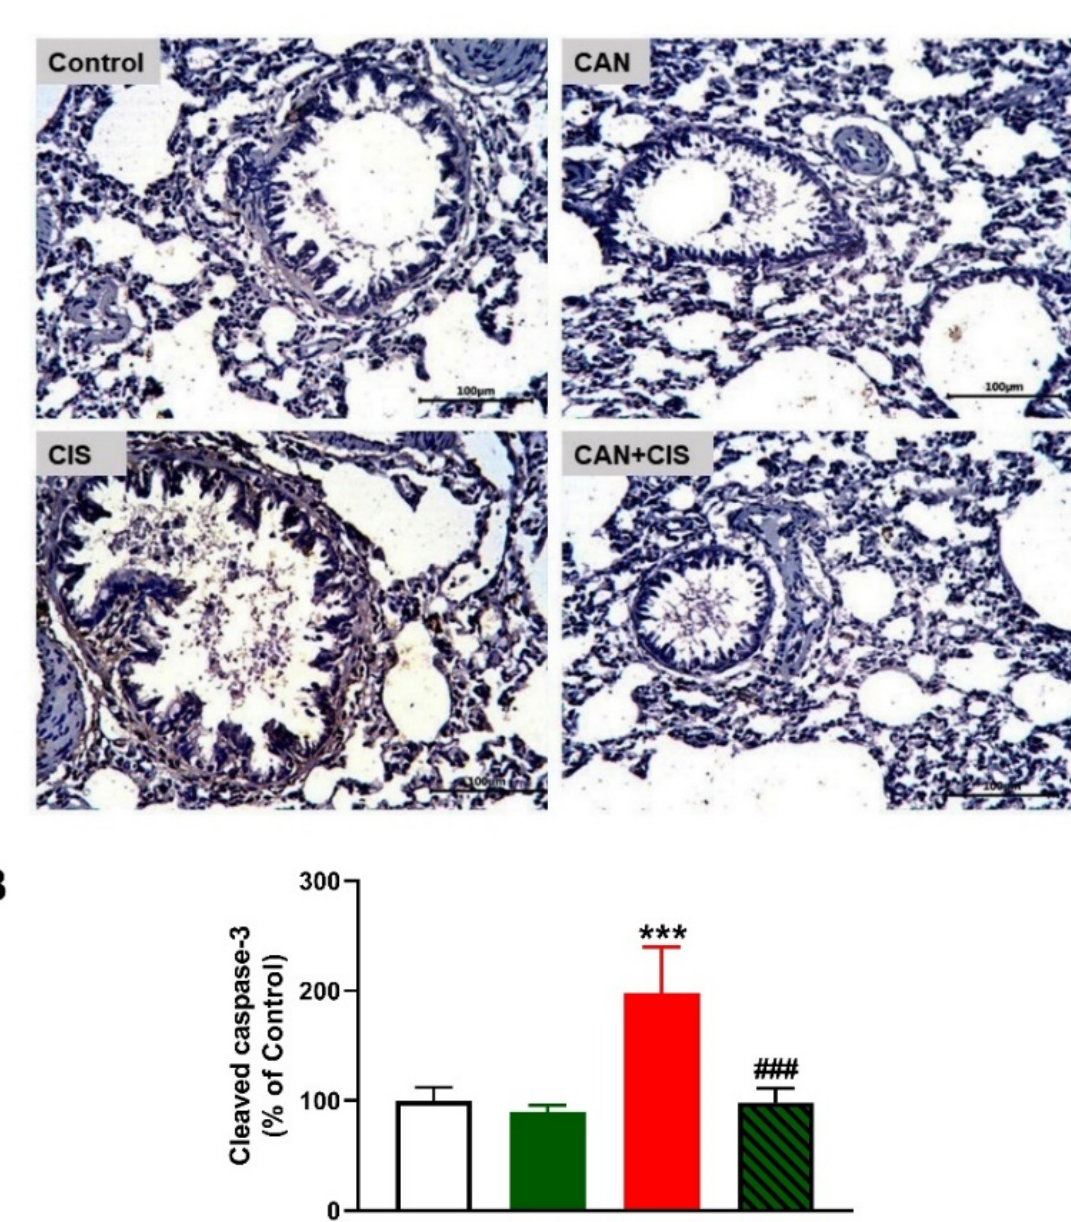
Figure 5. CAN downregulated cleaved caspase-3 in CIS-administered rats. ( A ) Photomicrographs of sections in the lungs of rats showing increased expression of cleaved caspase-3 in CIS-administered rats and a marked decrease in CAN-treated rats. ( B ) Image analysis showed that CAN significantly decreased cleaved caspase-3 in CIS-administered rats. Data are Mean ± SEM, ( n = 8). *** p < 0.001 vs. Control and ### p < 0.001 vs. CIS.